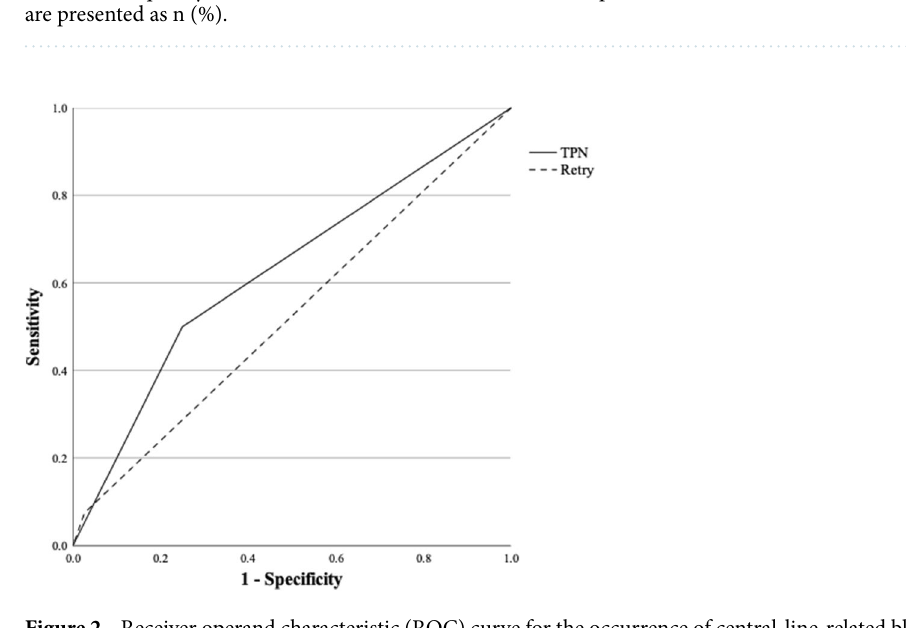
Figure 2. Receiver operand characteristic (ROC) curve for the occurrence of central-line-related bloodstream infection